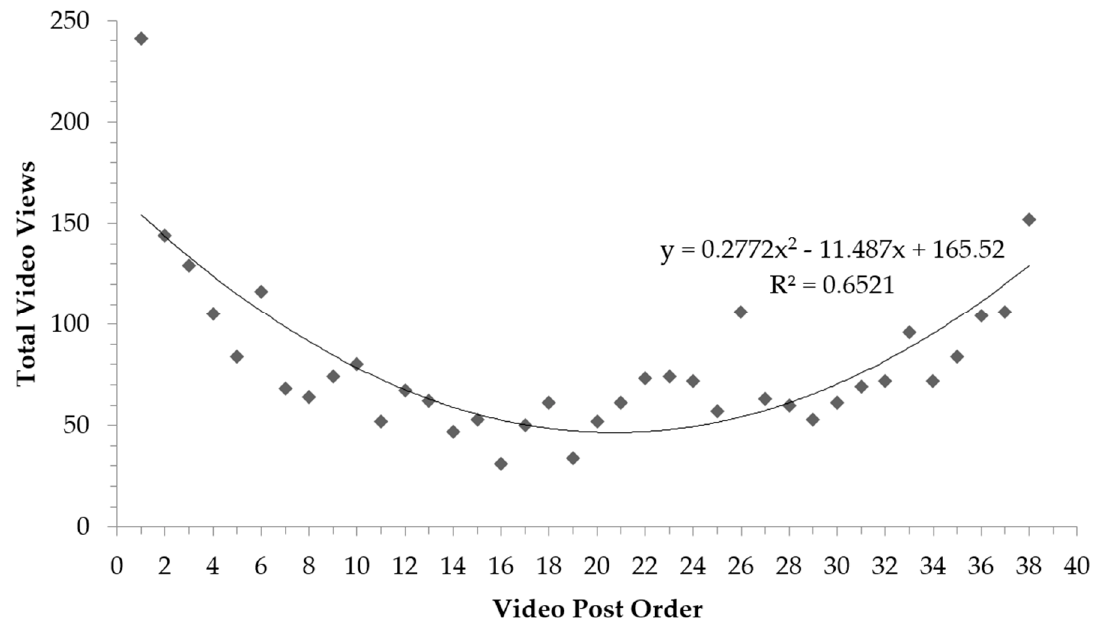
Figure 4. Quadratic regression model of total video views and video post order.